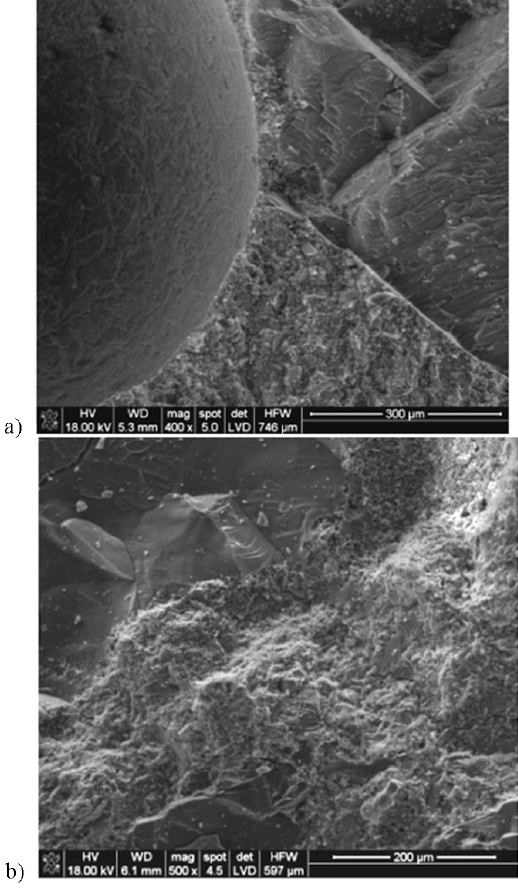
Fig. 13. SEM research results of SCC for non-air-entraining PCP: a) porosity; b) CSH